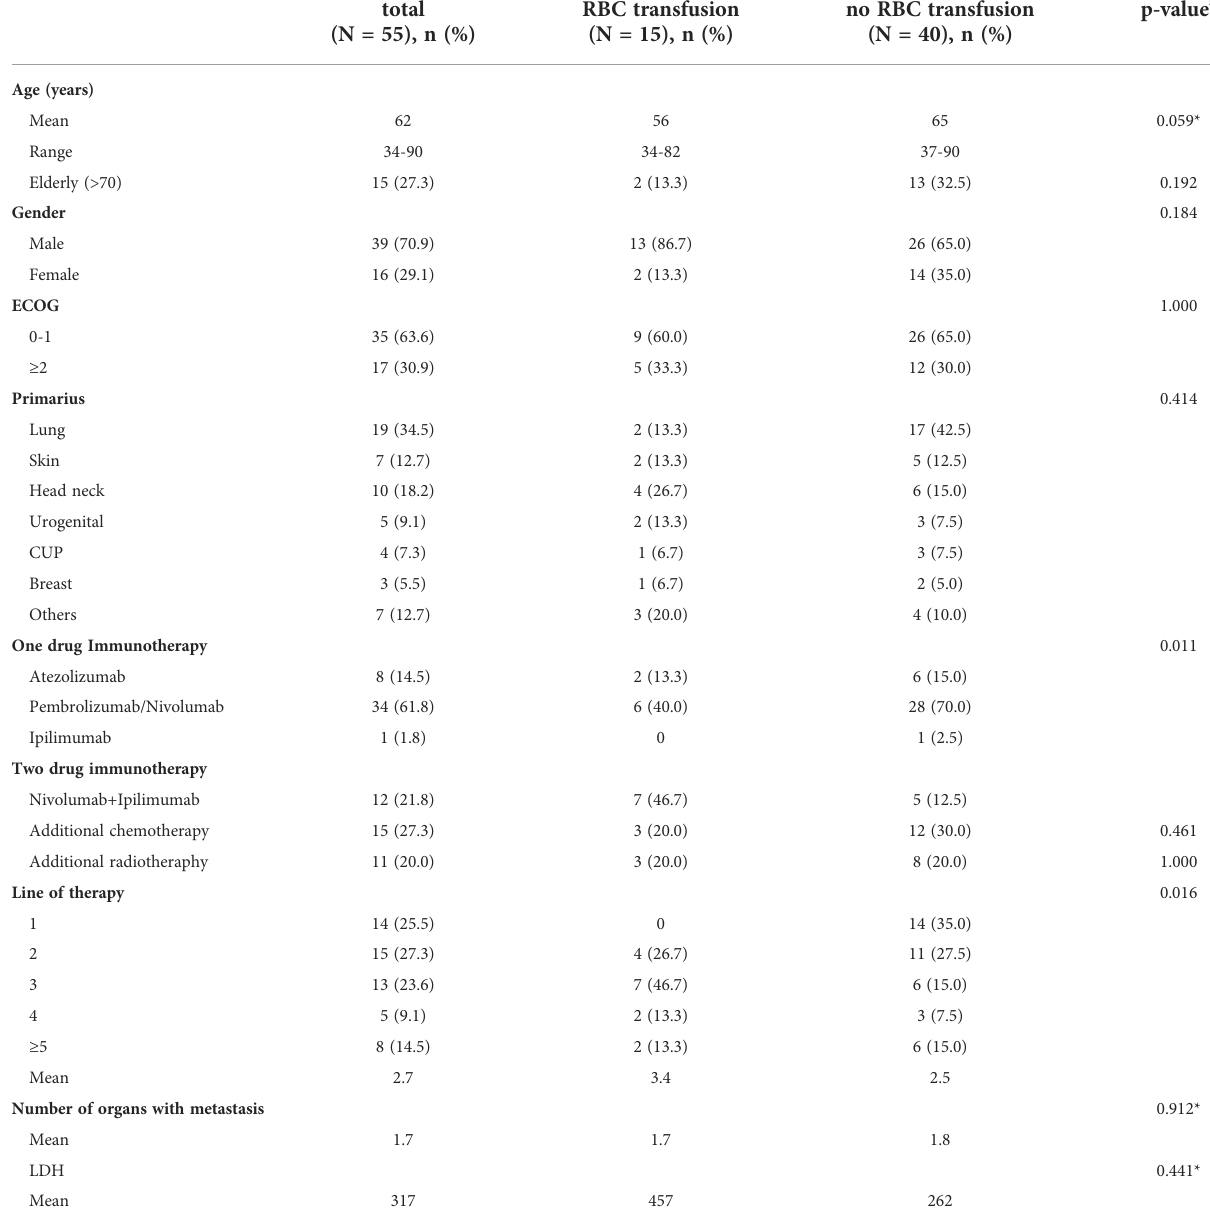
TABLE 1 Patient characteristics of transfused and non-transfused patients (in the fi rst 60 days after IT